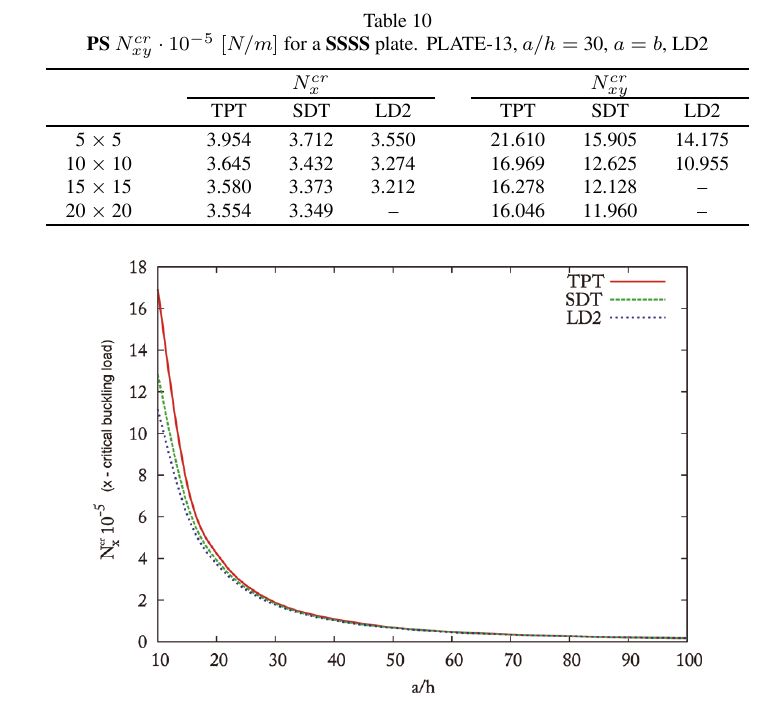
Fig. 3. UAC on a SSSS plate. PLATE-31, Q4, 10 × 10, a = b.